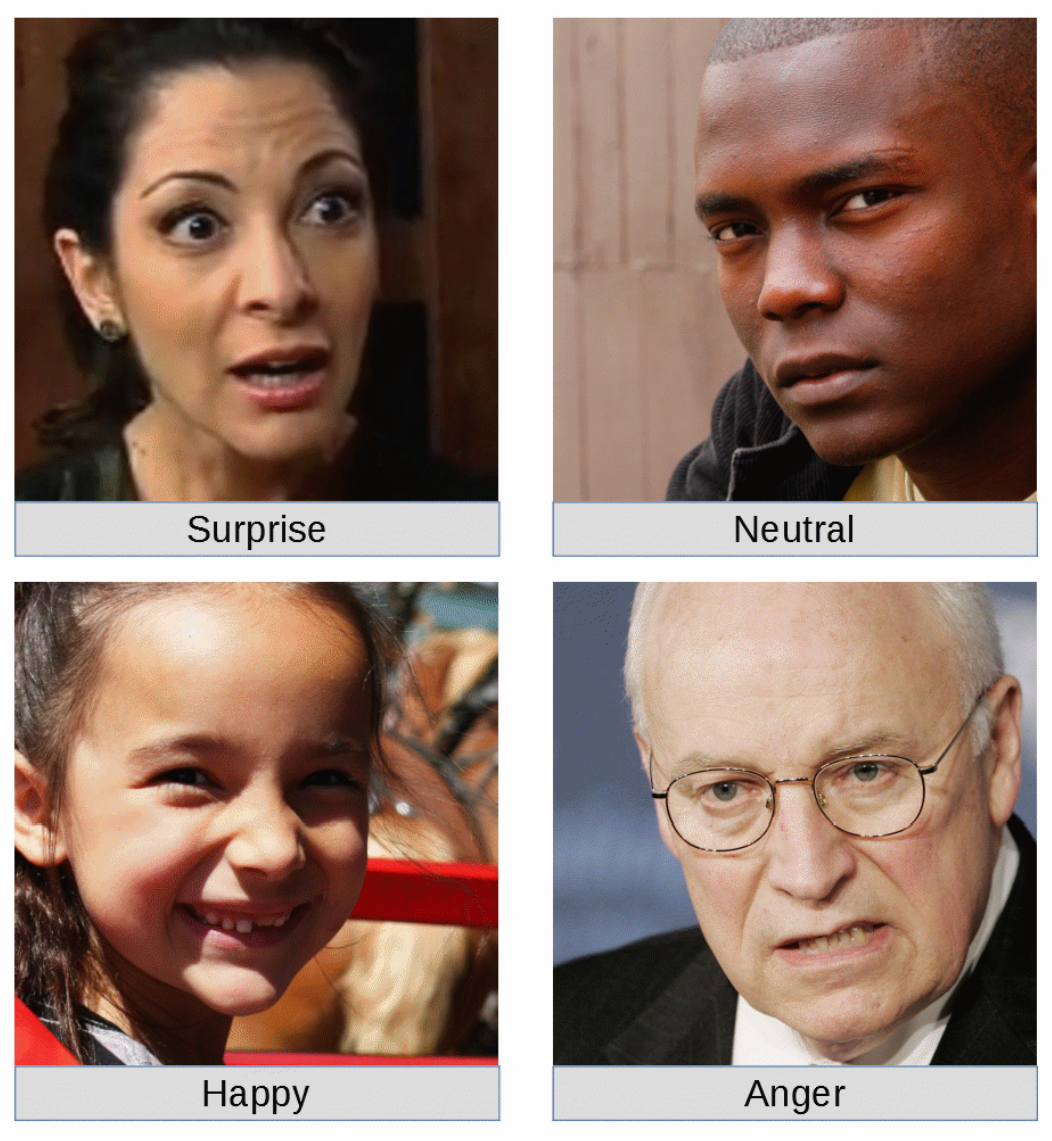
Figure 4. Sample images from the filter